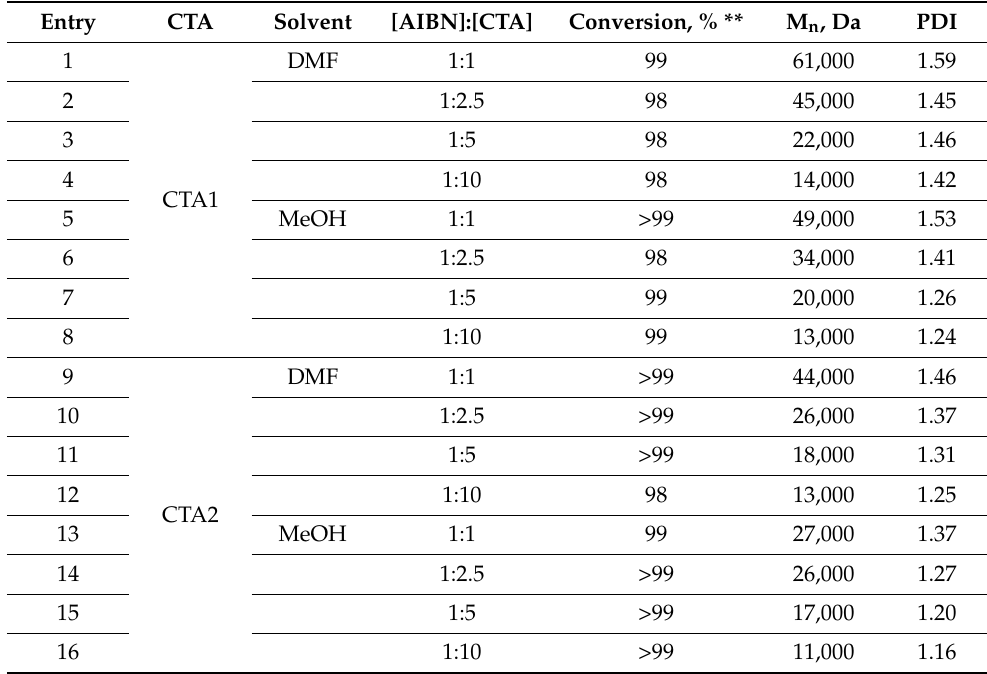
Table 2. The synthesis conditions and characteristics of poly(1-vinyl-1,2,4-triazole) obtained by the RAFT polymerization in DMF or MeOH, at different ratios of AIBN and CTA at 60 ◦ C for 24 h